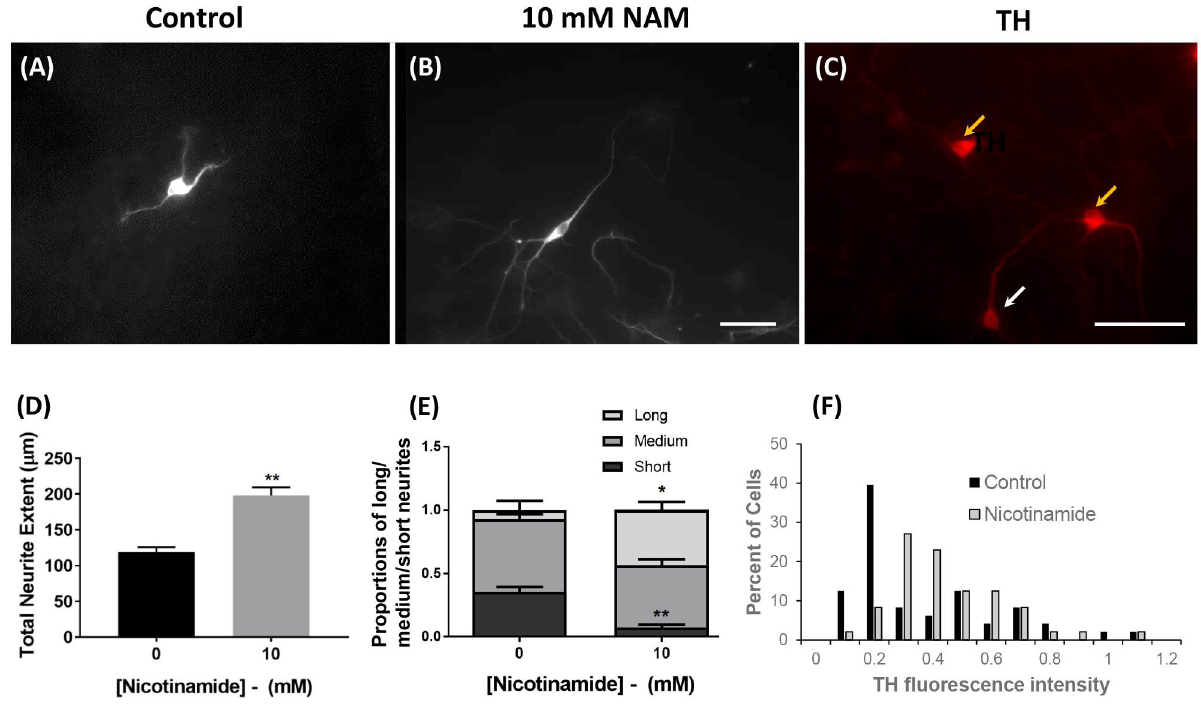
Fig 2. Nicotinamide enhances neuronal maturation in tyrosine hydroxylase-expressing neurons populations. The proportion of 46C-derived cells displaying “short” primary processes was significantly decreased at day 14, in cultures exposed to 10 mM nicotinamide between days 0 and 7, concomitant with an obvious increased trend towards “longer” neurite processes, compared with controls (A-B, D-E). At day 14, cells showed intense TH immunoreactivity (yellow arrows) or less strong TH expression (white arrow) (C). Addition of nicotinamide enhanced the number of neurons expressing strong TH immunofluorescence (F). Scale bars = 50 μ m. �� p < 0.01, � p < 0.05.